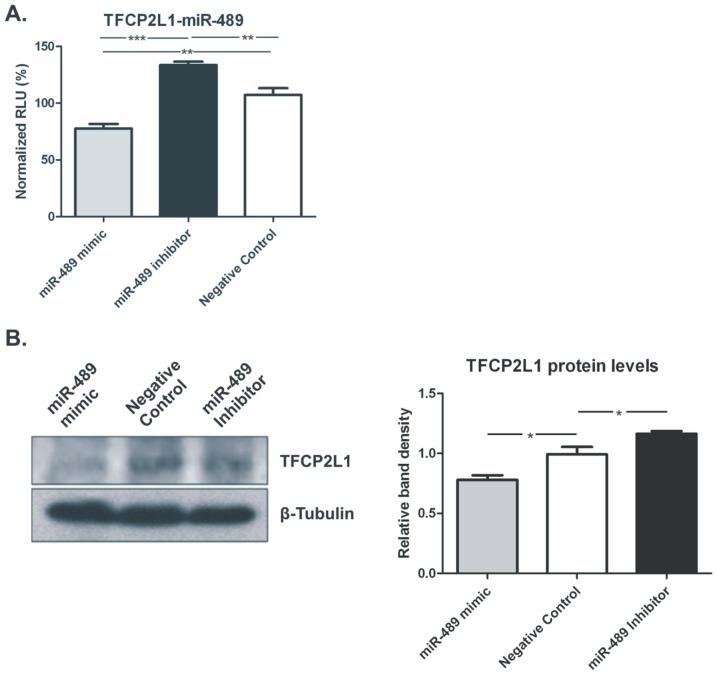
Western blotting.A. Normalized luciferase relative light units (RLUs) in AB8/13 cell lysates after transfection with sensor constructs. Co-transfection of pMIR-REPORT-TFCP2L1 with either miR-489 mimic or inhibitor resulted in significant reduction or increase in luciferase expression versus the negative control, respectively, indicating that miR-489 binds directly on the 3′UTR of TFCP2L1 (***, p<0.001; **p<0.05, ANOVA). B. Western blot of TFCP2L1 from AB8/13 cells after transient transfection with miR-489 miRNA LNA mimics, Inhibitors and the AllStars™ Negative Control scrambled sequence LNA. This is a representative of three experiments.The statistical analysis of western blot densitometry results, normalized against the Negative Control is also depicted. Values represent the mean ± SEM. Results illustrate the reduction of TFCP2L1 protein levels at the presence of miR-489 mimics (*, p = 0.026), while miRNA Inhibitors significantly increased TFCP2L1 levels (*, p = 0.039).